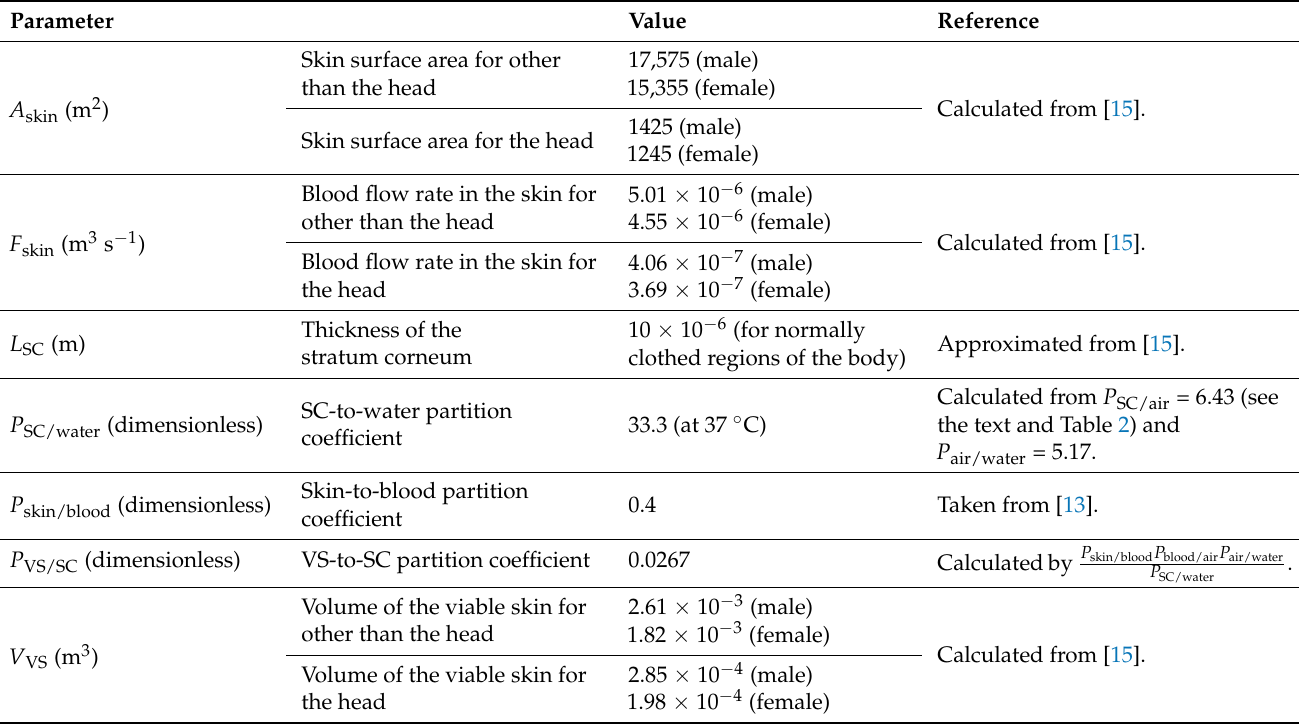
Table 1. Parameters necessary for modeling the diffusion of radon in the stratum corneum.